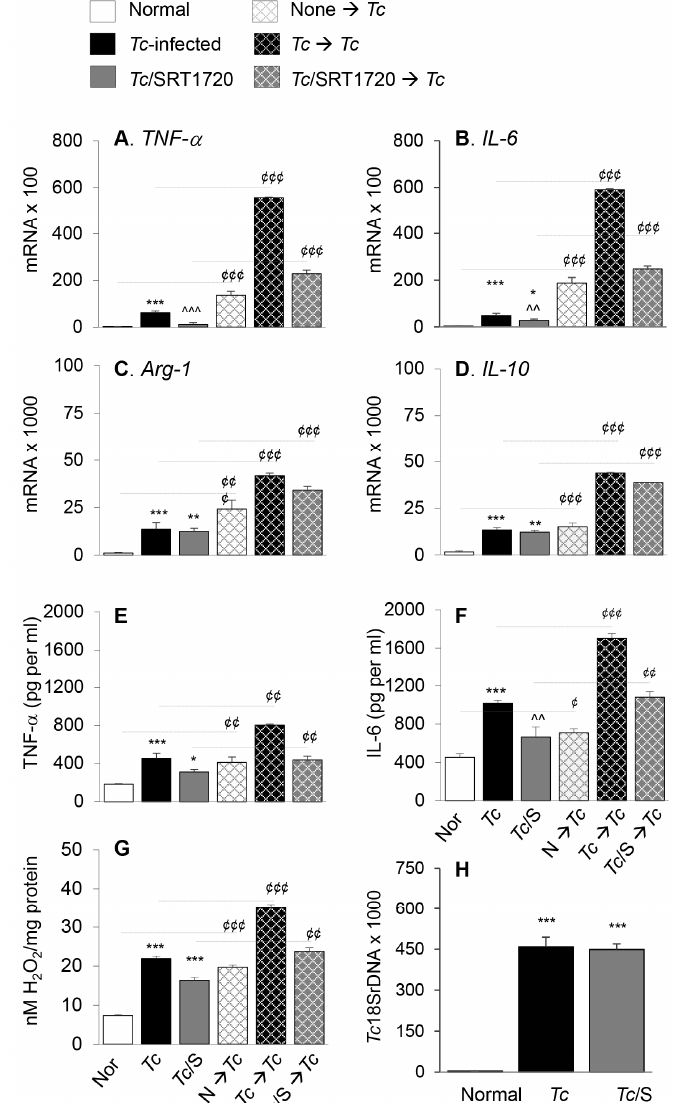
Figure 4. Functional activation of splenic Mo / M ϕ in Chagas mice in presence or absence of SRT1720, and recall response to T. cruzi . Mice were infected with T. cruzi ( Tc ), treated with SRT1720 (S), and euthanized as in Figure 2A. Splenic Mo / M ϕ were isolated by using MACS CD11b MicroBeads as described in Materials and Methods. Purified splenic Mo / M ϕ from normal (none), Tc -infected and infected / SRT1720-treated mice were incubated with media alone (solid bars, no pattern) or with Tc (bars with cross-pattern) for 24 h to observe the recall response ( A – D ) Real time RT-qPCR evaluation of mRNA levels for TNF- α ( A ), IL -6 ( B ), Arg-1 ( C ), and IL-10 ( D ). For each target gene, Ct values were normalized to GAPDH expression. ( E – F ) An ELISA was performed to determine the TNF- α ( E ) and IL-6 ( F ) levels in cell-free supernatants. ( G ) ROS levels in the supernatants were measured by Amplex Red assay. For panels A–G, data (mean value ± SEM) are derived from two independent experiments ( n = 3–5 mice per group per experiment, duplicate ( A – D ) or triplicate ( E – G ) observations per sample). ( H ) Level of parasite burden in splenic Mo / M ϕ was determined by quantitative PCR amplification of the Tc18SrDNA sequence and normalized to GAPDH sequence. ( n = 5 mice per group, duplicate observations per sample). Statistical significance is annotated as * normal vs. infected groups, ˆ Tc vs. Tc / SRT1720, and ¢ splenic Mo / M ϕ in vitro stimulated with Tc vs. matched non-stimulated Mo / M ϕ . * , ¢ denote p value of < 0.05; ** , ˆˆ , ¢¢ denote p value of < 0.01; and *** , ˆˆˆ , ¢¢¢ denote p value of <